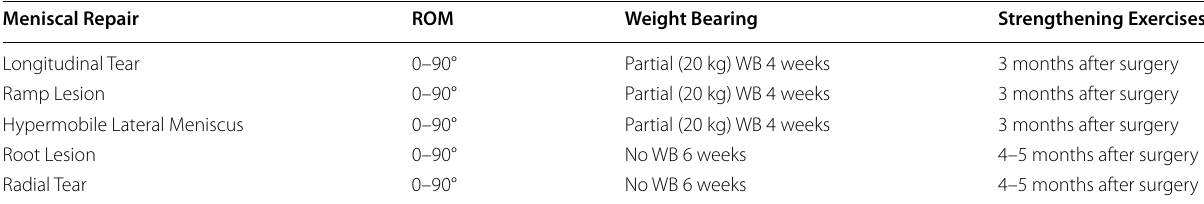
WB Weightbearing, ROM Range of motion